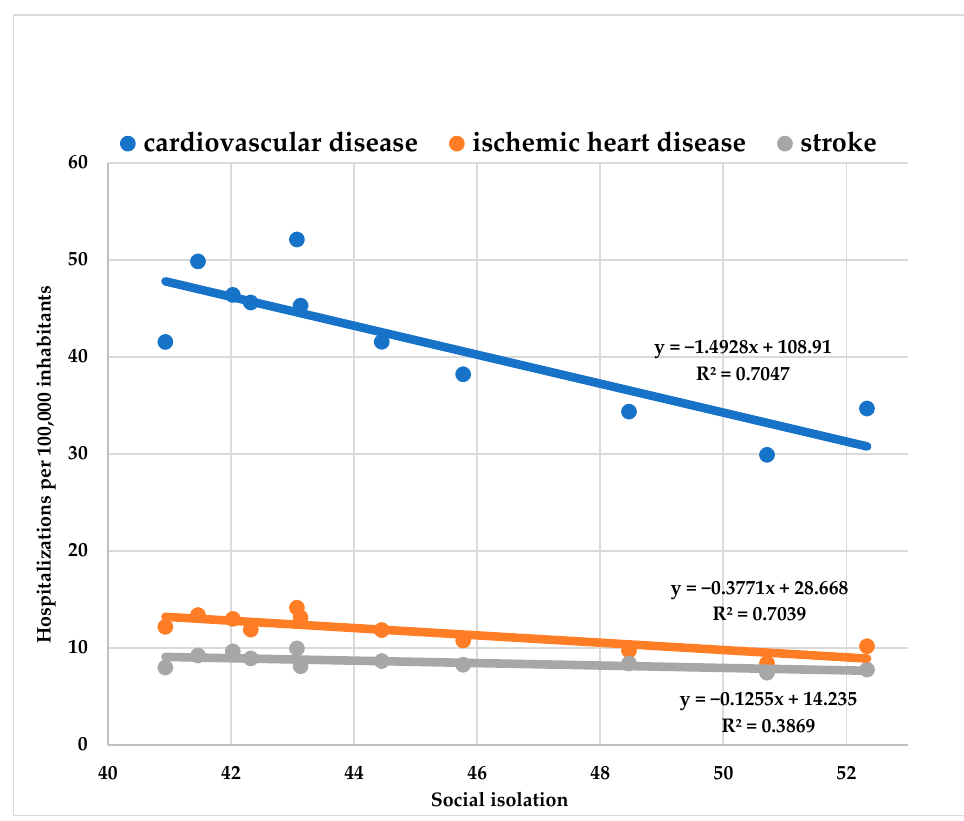
Figure 1. Correlation between weekly social isolation and hospitalization per 100,000 inhabitants from cardiovascular disease, ischemic heart disease, and stroke.